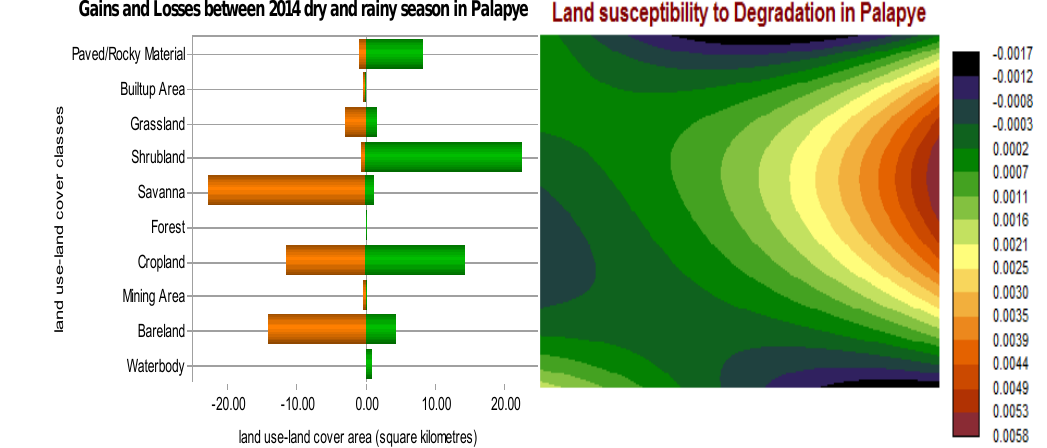
Figure 4: Gantt chart showing the gains and losses of LULC types between dry and rainy season in 2014 in Palapye.